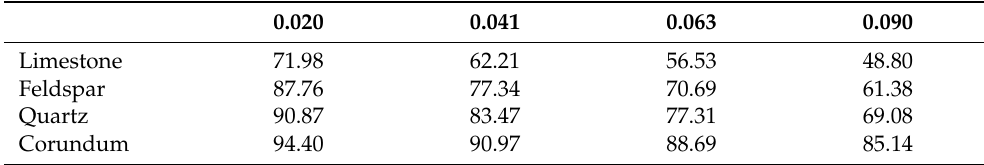
Table 8. Sieve analysis of materials after grinding, over sieve